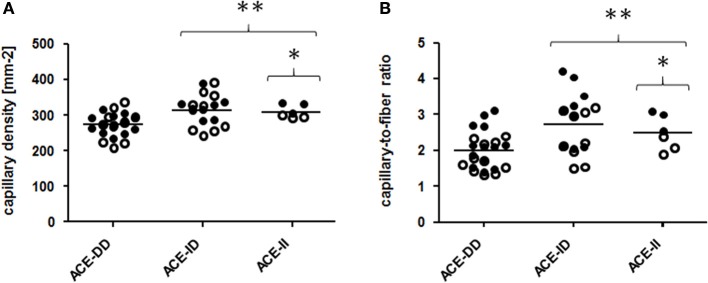
Effect of ACE-I/D genotype on muscle capillarisation. Scatter dot plot of the individual values and means of capillary density (A) and capillary to fiber ratio (B) for the 52 studied subjects when split for ACE-I/D genotype (26xACE-DD, 20xACE-ID, 6xACE-II). Filled and non-filled symbols in (A,B) indicate values of the trained and untrained subjects, respectively. * denotes *p < 0.05 vs. ACE-DD; **p < 0.01 vs. ACE-DD. Univariate ANOVA with post hoc test of Fisher. Only genotype effects are indicated.